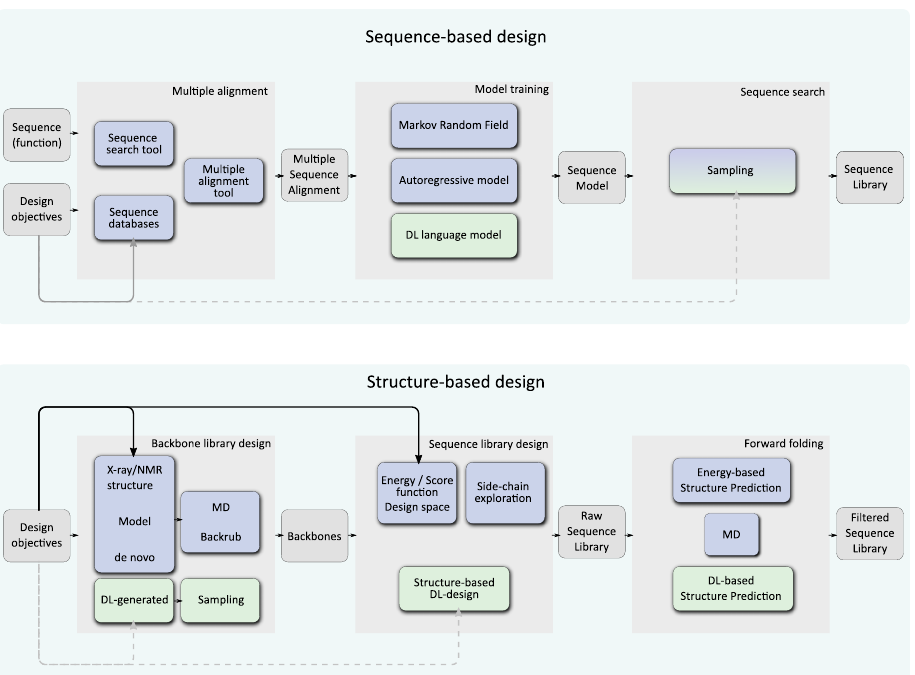
Figure 1. General workflows for computational protein design. Deep Learning-based approaches are represented in green, other approaches are in blue. The top workflow represents pure sequence- based approaches where a sequence, capturing a function is used to scan sequence databases in order to build a multiple sequence alignment. This alignment is used to train a machine or deep learning model that can be sampled to produce a sequence library. The bottom workflow is for structure-based computational protein design. One or several backbones (if multistate/flexibility is sought) are generated and possibly locally or globally perturbed. These can be exploited by usual energy/score function based method exploring a design space of possible rotamers (blue) or DL-based design (green). The resulting sequence library can be filtered using “forward folding”: randomized predictions are used to check if the sequence is predicted to reliably fold on its target backbone. The design objectives (beyond reaching the target fold itself) can be taken into account at different steps in these workflows (arrows). Traditional energy-based design offers several opportunities to inject these objectives in the design process: during backbone design, in the optimized score function, by combining them with the approximate free energy function used for optimization and also in the sequence/conformation space explored. In sequence-based design, such capabilities are strongly constrained by the landscape of existing proteins but some control may still be possible during the selection of the learning data-set and the sampling procedure. Most structure-based Deep learning approaches offer little or no control beyond backbone design (dotted